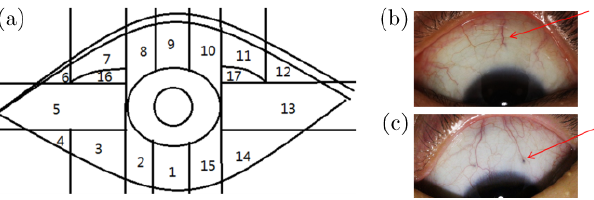
Fig. 3. Schematic diagram of eye-feature and eye-feature images of normal people and patient with kidney de¯ciency. (a) Schematic diagram of eye-feature diagnosis in Chinese medicine for left eye: (1) stomach; (2, 15) spleen; (3) large in- testine; (4) small intestine; (5) heart; (6) breast; (7) lung; (8, 10) kidney; (9) bladder; (11) ovary (testis); (12, 14) liver; (13) gallbladder; (16) brain; (17) lumbosacral. (b) Eye-feature image of normal people. (c) Eye-feature image of people with kidney de¯ciency.